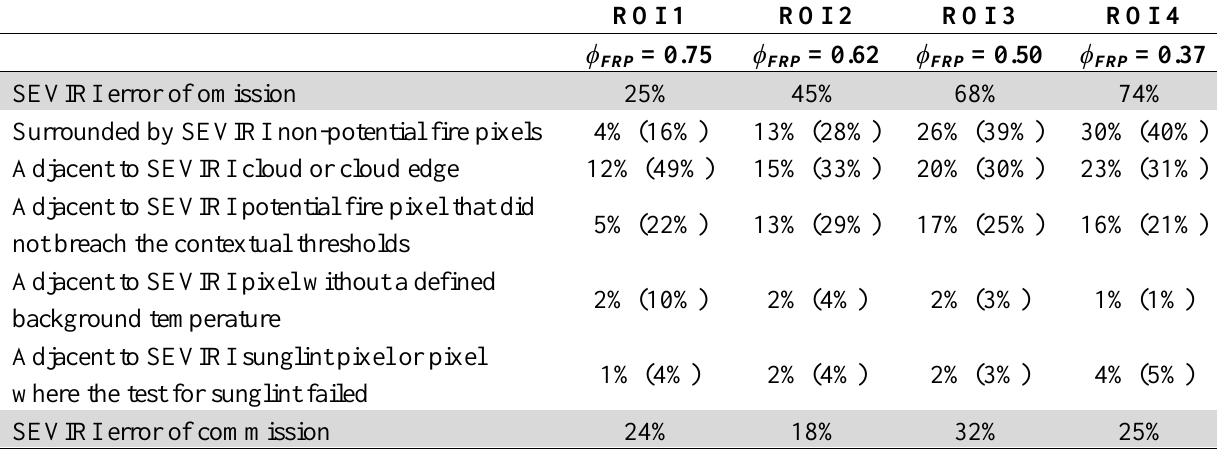
Table 2. Seasonal SEVIRI errors of omission and commission (shown in gray) for each region of interest (ROI) depicted in Figure 1a between 1 October 2008 and 30 April 2009. Errors of omission are decomposed into five potential reasons for the failed SEVIRI detection. Open values indicate the absolute proportion of MODIS active fire pixels missed by SEVIRI as a result of a particular artefact, and values in parentheses indicate the relative proportion of SEVIRI’s omission rate in an ROI attributed to a particular